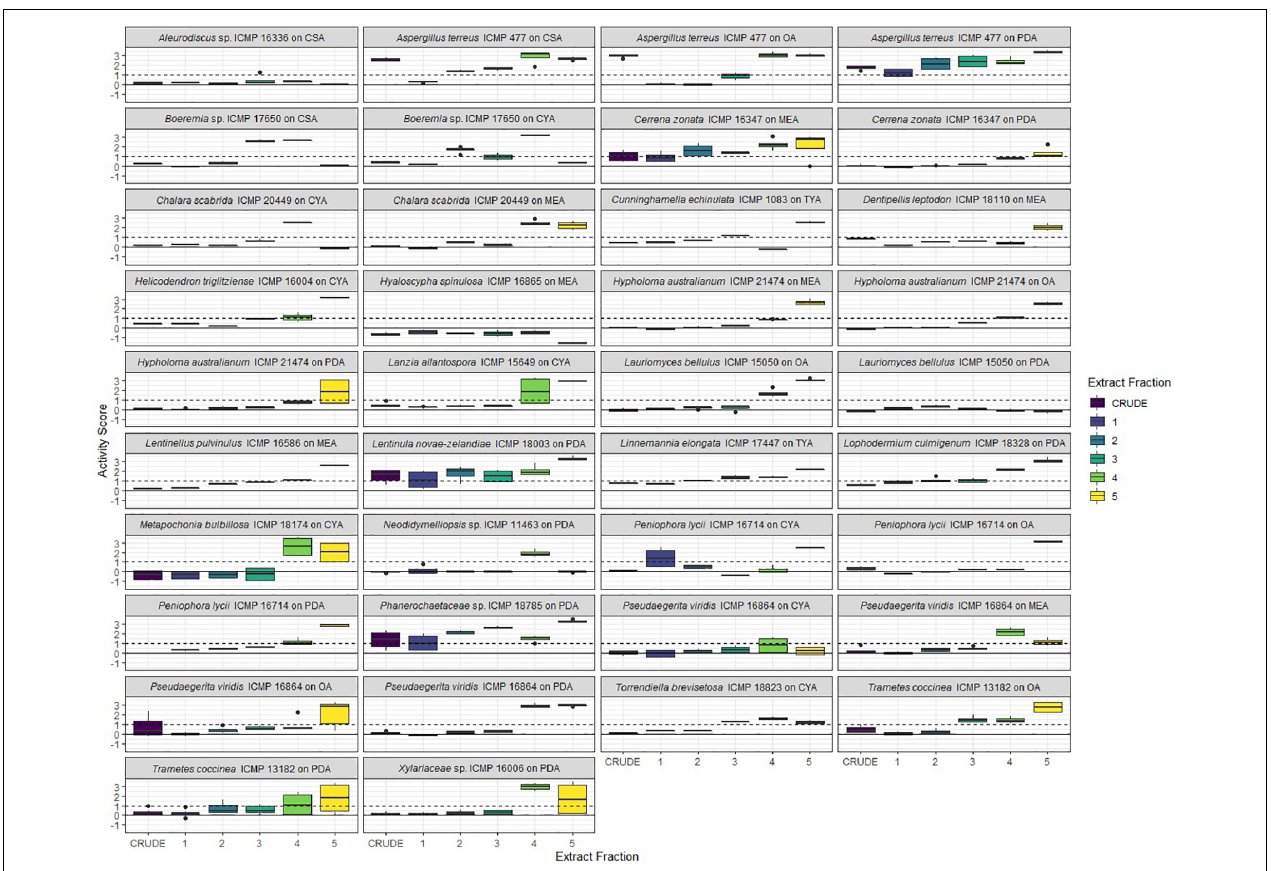
FIGURE 6 | Antibacterial activity of crude extracts and fractions 1–5 from ICMP fungal isolates against Mycobacterium marinum BSG101. Data is presented as box and whisker plots of activity scores. The solid line shown at 0 is the median control value while the dotted line at 1 is the activity threshold. Scores above 1 correspond to a > 90% reduction in bacterial bioluminescence compared to the corresponding no-fungi control. Similarly, an activity score above 2 means corresponds to a > 99% reduction. CSA, Czapek Solution Agar; CYA, Czapek Yeast Extract Agar; MEA, Malt Extract Agar; OA, Oatmeal Agar; PDA, Potato Dextrose Agar; TYA, Tryptone Yeast Extract Agar. Boxes are upper and lower quartiles with median shown. The whiskers extend up to 1.5 × the inter-quartile range and any dots beyond those bounds are